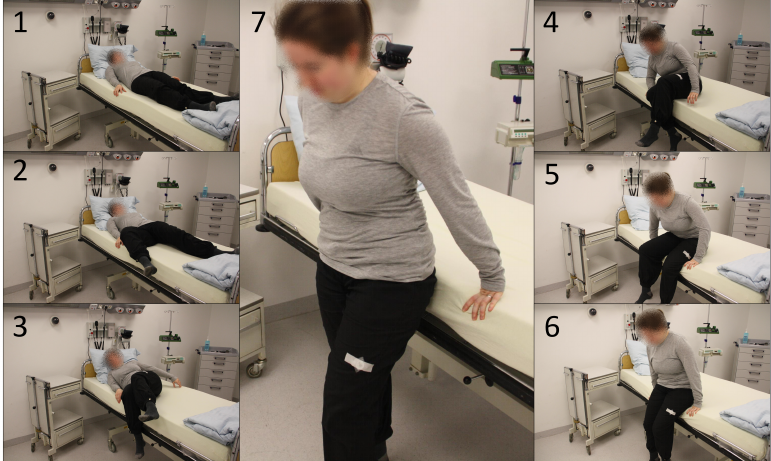
Figure 13. Procedure of a general rising out of bed, represented by seven phases from lying down over sitting on the edge of the bed to the uprising